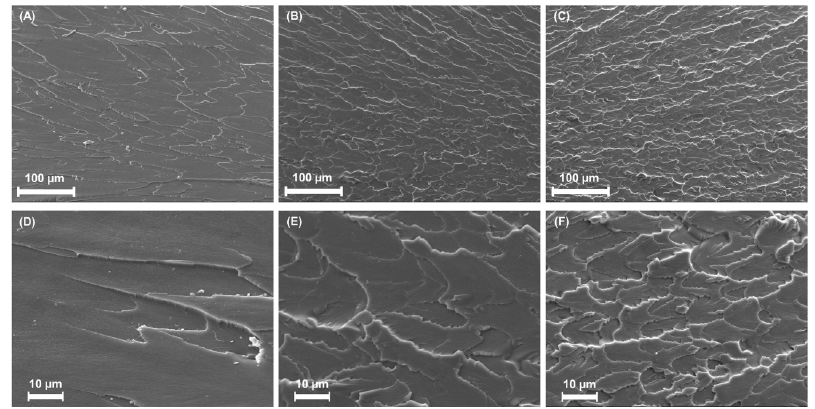
Figure 4. SEM images of ( A,D ) the control; ( B,E ) ND-; and ( C,F ) A-ND-incorporated nanocomposites, showing clear differences in fracture-surface patterns. ( A–C ) 250 × and ( D–F ) 1000 ×